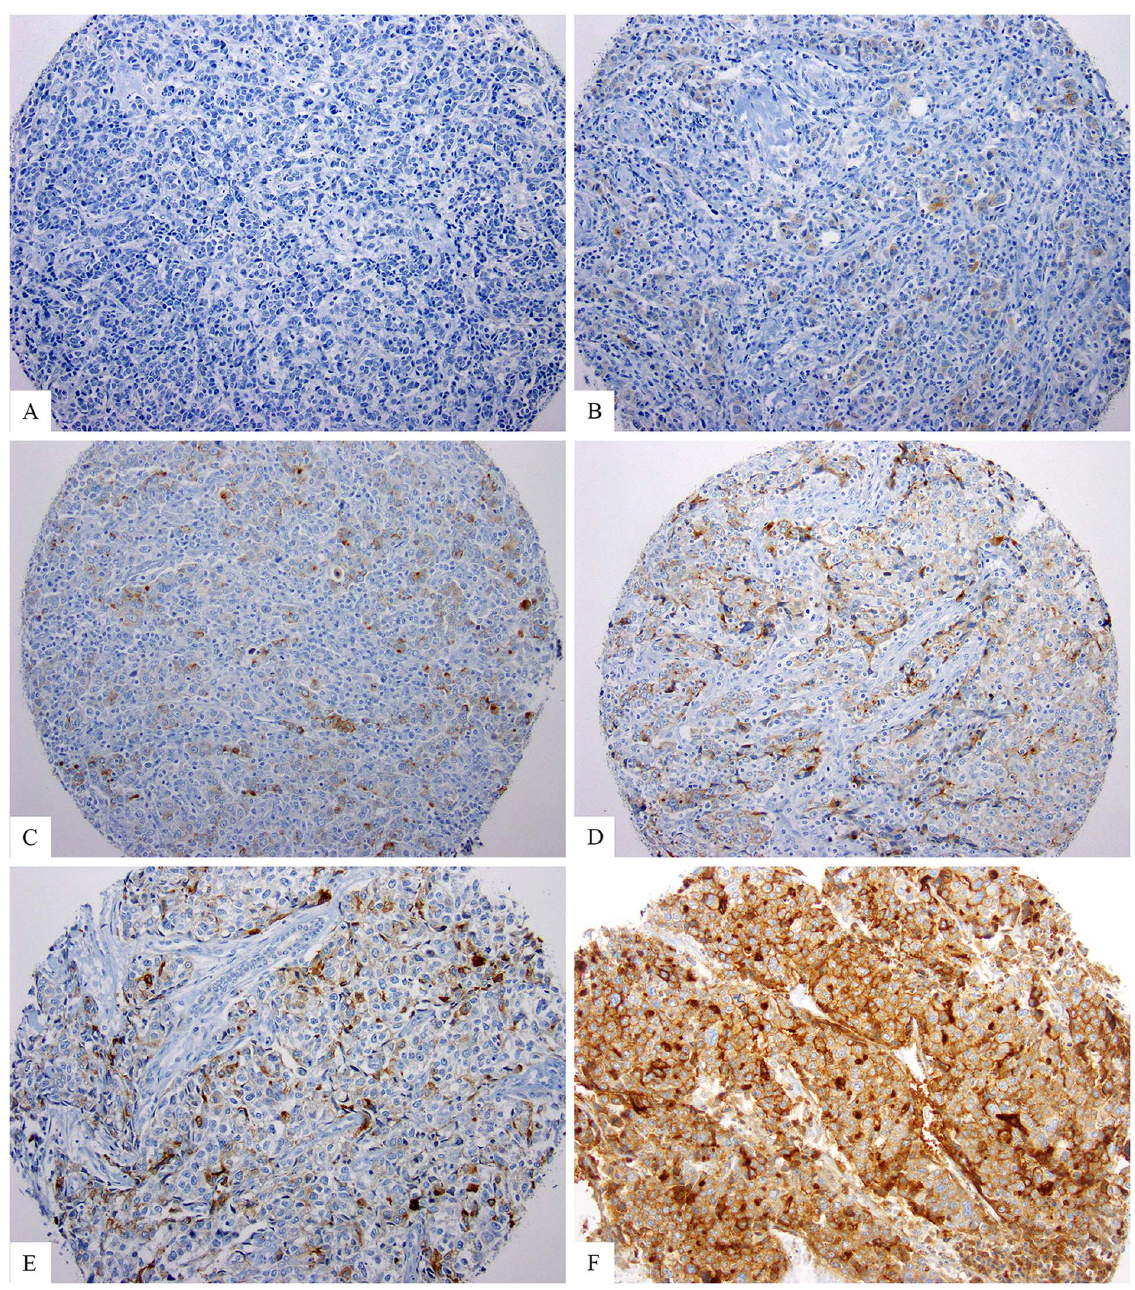
Fig. 1. Examples of immunohistochemical staining for MSLN in TNBC. A and B) MSLN negative. A) No staining. B) Percentage score 5 1 (1–50%), intensity score 5 1 (weak), final score 5 2. C–F) MSLN positive. C) Percentage score 5 1 (1–50%), intensity score 5 2 (moderate), final score 5 3. D) Percentage score 5 2 ( . 50%), intensity score 5 1 (weak), final score 5 3. E) Percentage score 5 2 ( . 50%), intensity score 5 2 (moderate), final score 5 4. F) Percentage score 5 2 ( . 50%), intensity score 5 3 (strong), final score 5 5.